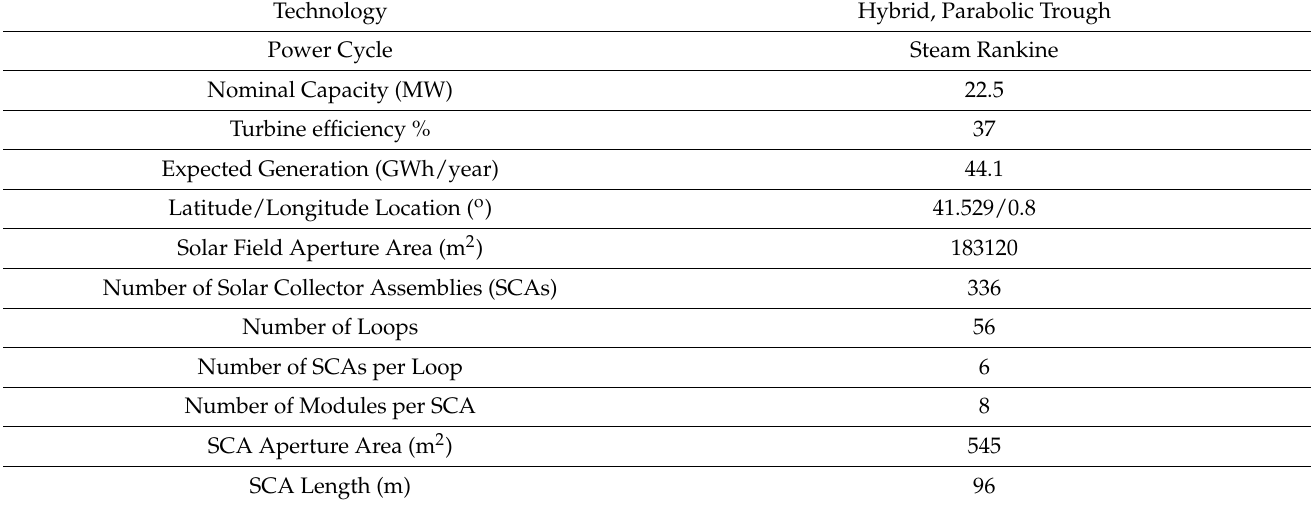
Table A2. Technical data of Solar Field CSP.